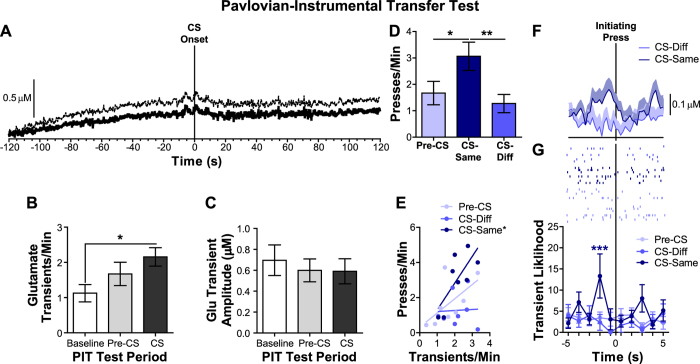
Basolateral amygdala glutamate release during Pavlovian-instrumental transfer.(A) Average glutamate concentration change (μM) during the 2-min conditioned stimulus (CS) presentation (beginning at time 0 s) and immediately preceding 2-min pre-CS period averaged across trials during the PIT test for each rat and then averaged across rats. Dashed lines represent the between-subjects +1 SEM. (B) Glutamate transients that reached threshold were counted and averaged for each rat across the 2-min pre-test baseline period, the 2-min pre-CS periods and the 2-min CS periods. (C) Glutamate transient the amplitude (μM) was calculated as the peak amplitude of the transient minus the baseline glutamate concentration. (D) Lever-press rate (Presses/min) averaged across levers during the control Pre-CS periods compared to pressing during CS presentation distinguished by whether it was on lever that, in training, earned the same outcome as predicted by the presented CS (CS-Same Actions) relative to pressing on the opposite lever (CS-Diff Actions). Main effect of CS: F2,14 = 8.85, p = 0.003. (E) Glutamate transient frequency (Transients/min) v. lever-press rate (Presses/min) between-subjects correlation. (F) Glutamate concentration v. time traces for the 5 s prior to and after initiating presses (occurring at time 0 s) during the CS averaged across all initiating presses for a representative subject. Shading reflects +1 SEM across trials. (G) The likelihood of a glutamate transient distributed in 1-s bins, 5 s prior to and after initiating presses (occurring at time 0 s; first press after a >6 s pause in pressing). Glutamate transient likelihood is defined as the percentage of initiating presses with a glutamate transient in the represented 1-s time bin. Asterisks represent significance relative to the first 1-s time bin. Raster plot displays corresponding raw data; each subject is represented on an individual line on the y-axis with tick color reflecting trial type. Tick marks represent the peak time of each glutamate transient that reached threshold surrounding initiating presses. Error bars +1 SEM. *p < 0.05, **p < 0.01, ***p < 0.001.